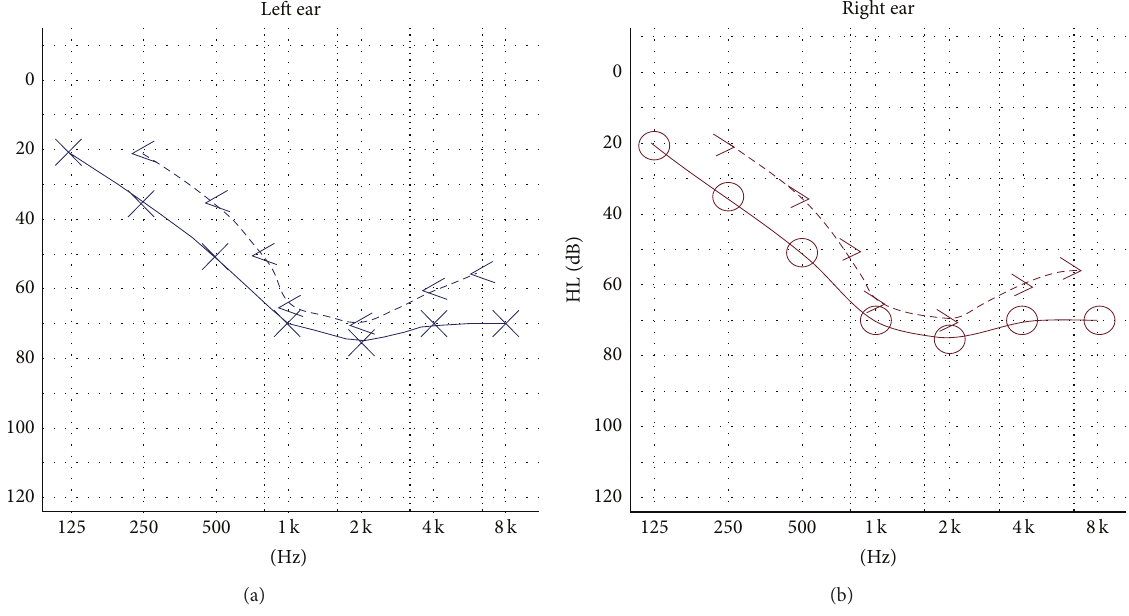
Figure 3: Pure tone audiometry showed bilateral moderate-to-severe hearing